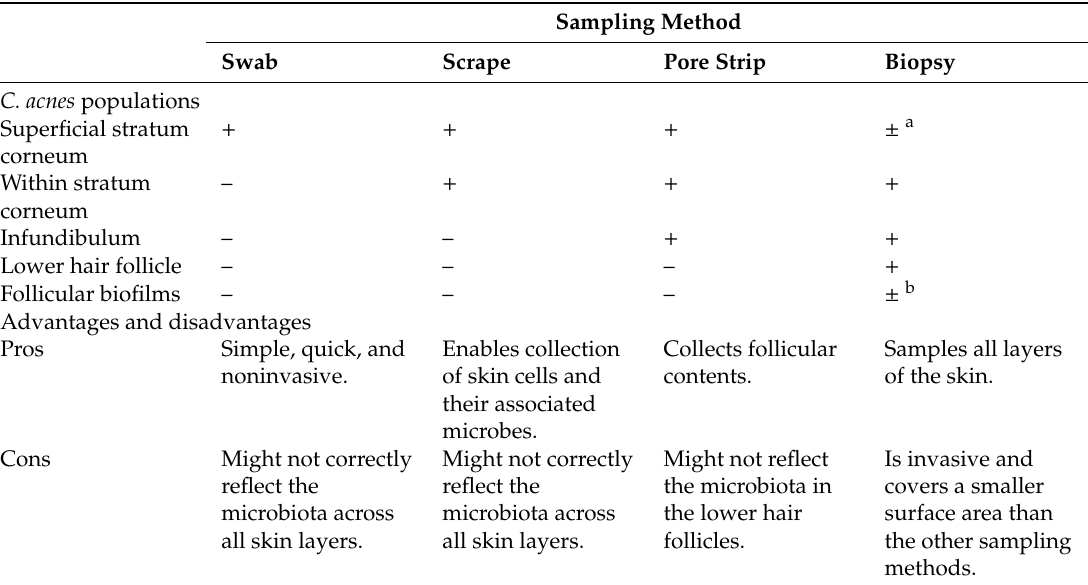
Table 1. Comparison of the different skin sampling methods.